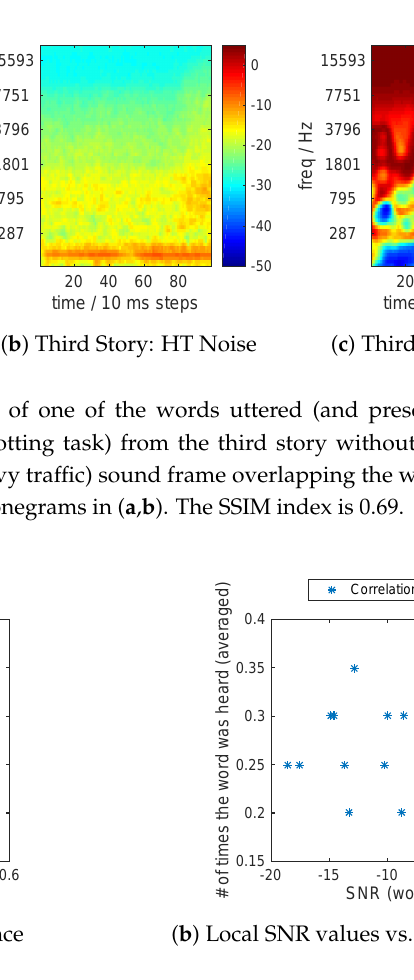
Figure 8. ( a ) The SSIM against the average number of times the words were identified for all stories; the correlation between them is shown on the legend; ( b ) local SNR values against the average number of times the words were identified for all stories; the correlation between them is shown on the